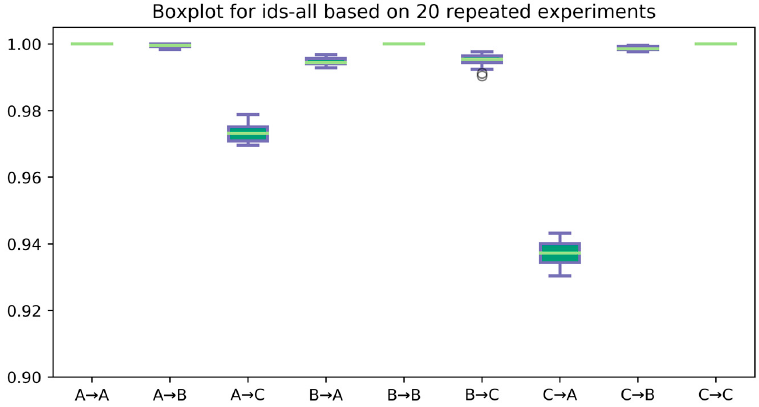
Figure 7. Accuracy of the best IDSCNN models on 20 repeated experiments.